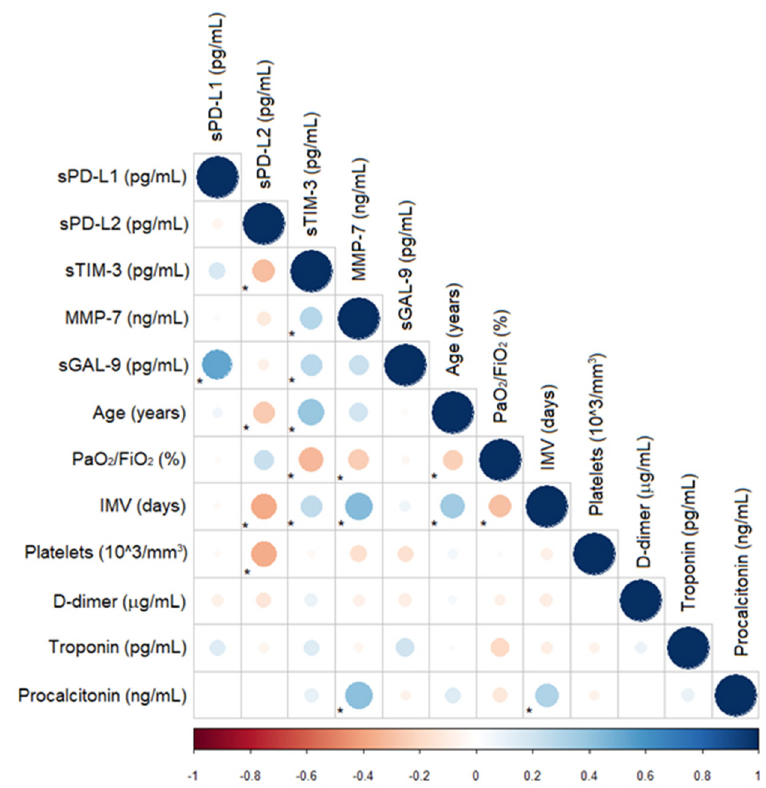
Figure 5. Correlogram for the association of the biomarkers with the clinical data. Blue dots represent a positive correlation, and red dots represent a negative correlation. The size and darkness of the dot are proportional to the value of the correlation coefficient. * p < 0.05. PaO 2 /FiO 2 , arterial pressure of oxygen/inspired fraction of oxygen.